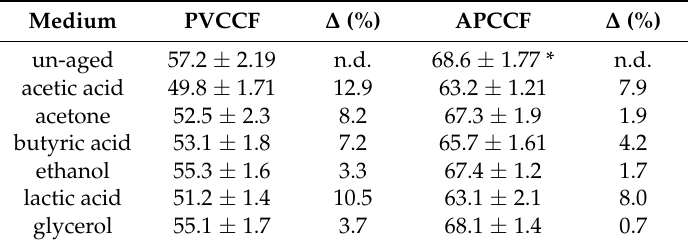
* The numbers after ‘ ± ’ represent the standard